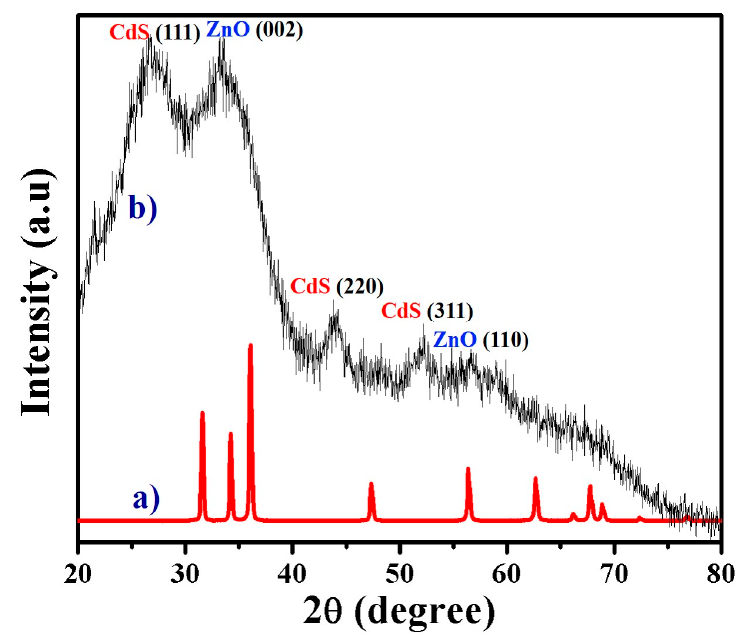
Figure 3. XRD patterns of the (a) ZnO NFs and (b) nanocomposite NFs obtained after calcination at 200 °C for 1 h.